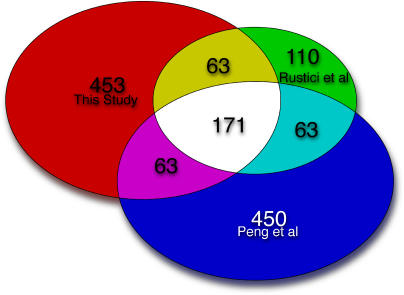
Overlap between Cell Cycle Microarray Studies, by Number of GenesA Venn diagram of the overlap between the three lists of cell cycle–regulated genes from this study, Rustici et al. [7], and Peng et al. [8]. The number of genes in each of the three lists is 750, 407, and 747, respectively. A few genes are not accounted for because of ambiguities in nomenclature.